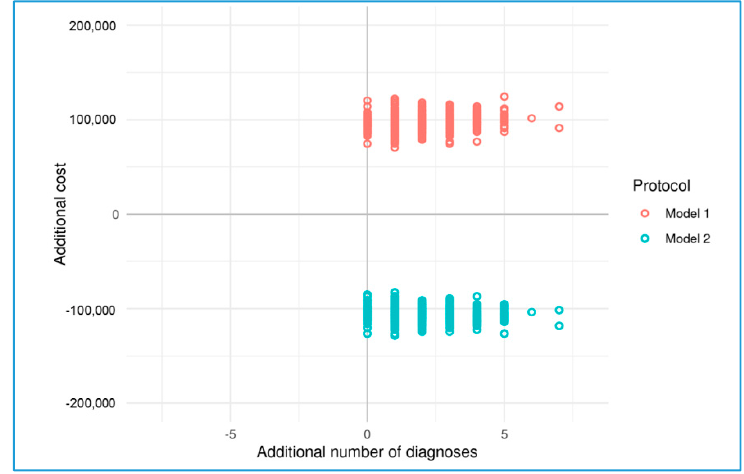
Figure 2. Cost-effectiveness plane comparing two different models to the standard diagnostic protocol (first and second step). Model 1: exome sequencing as the third-step test, and Model 2: exome sequencing as the first-step test. The additional number of diagnoses (effect) is plotted on the x-axis and the additional costs on the y-axis. Each point in the plane is derived from one of the 500 bootstrapped simulations and is represented on four quadrants. Since all points are distributed in the two right quadrants, both models produce a higher (or equal) number of diagnoses than the reference protocol. The area below the x-axis is cost saving, while the area above is cost increasing. This indicates that exome sequencing from the beginning with stepwise “virtual panel” testing is both clinically superior and cost-effective compared to the standard care and it is referred to as an economically “leading” strategy.